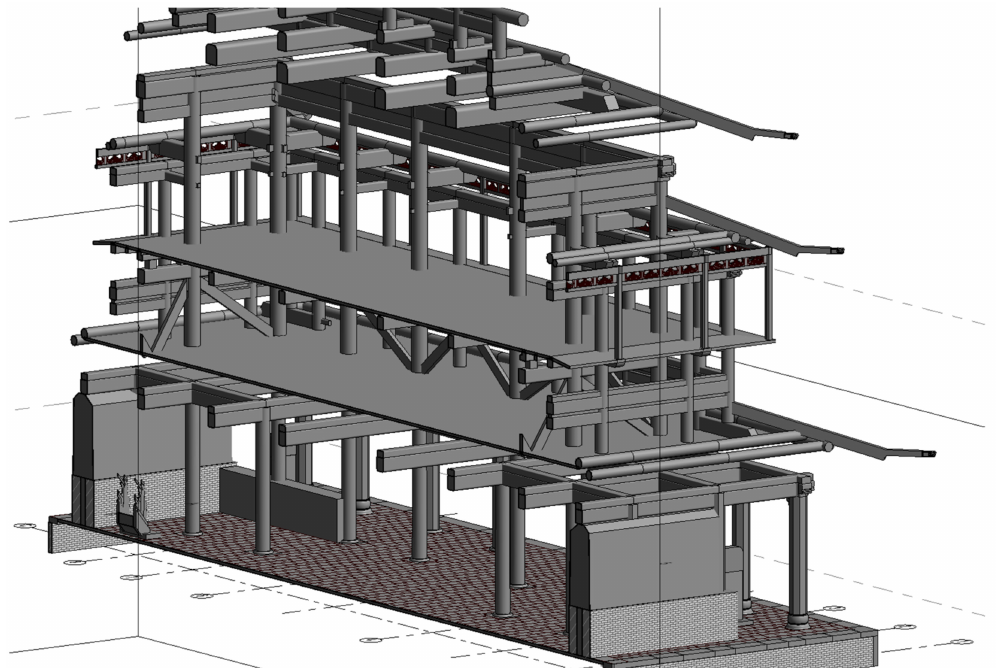
Figure 19. The Revit model of wooden structures.